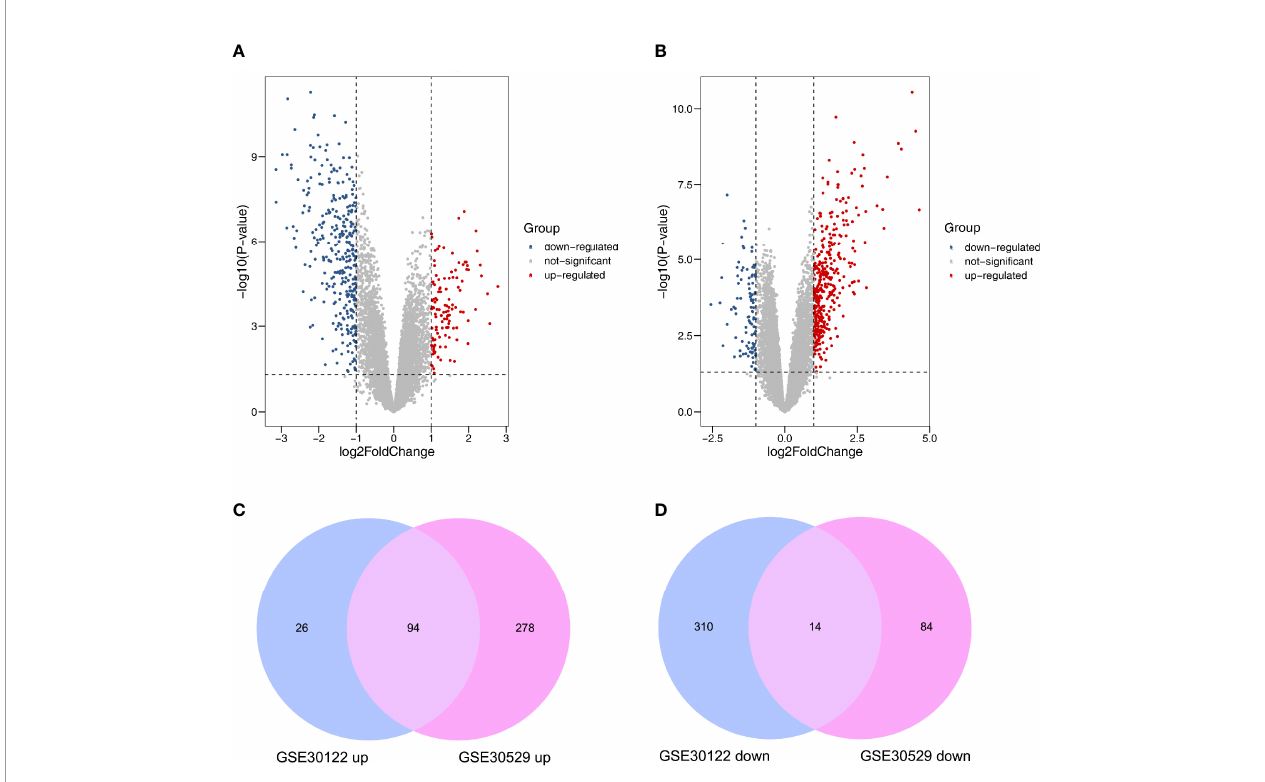
FIGURE 2 | Differently expressed mRNAs in DN. (A) GSE30122. (B) GSE30529. Red and blue dots represent up- and downregulated genes, and gray dots represent no differential expression genes. (C) Coexpression of upregulated genes. (D) Coexpression of downregulated